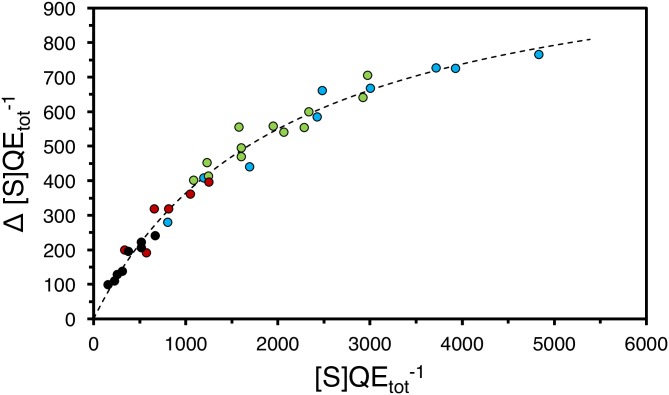
Rate of ampicillin hydrolysis events as a function of the number of available substrate molecules per enzyme per second.The figure contains data points of fibrils with a composition of 3x10-3:1 (blue), 6x10-3:1 (green), 12x10-3:1 (red), and 30x10-3:1 (black) with respect to the molar ratio of TEM1-Ure2(1–80) over Ure2(1–80). The data was fitted to Eq 10 by non-linear regression indicated by the dashed line. The absorbance measurements for each point were performed as triplicates.